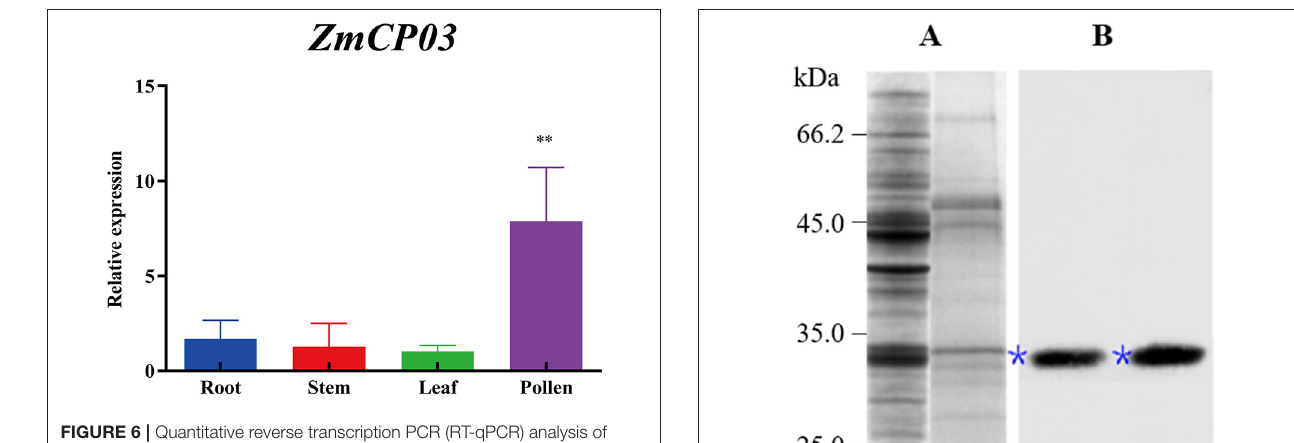
FIGURE 6 | Quantitative reverse transcription PCR (RT-qPCR) analysis of ZmCP03 in different organs of maize. Data presented are relative expression (mean ± SD) from the three biological replicates after normalization based on ZmUBI expression levels. Student’s t -test in the GraphPad Prism 8.0 software was used to compare significant differences (indicated by ** at p < 0.01) in expression levels among different tissues.